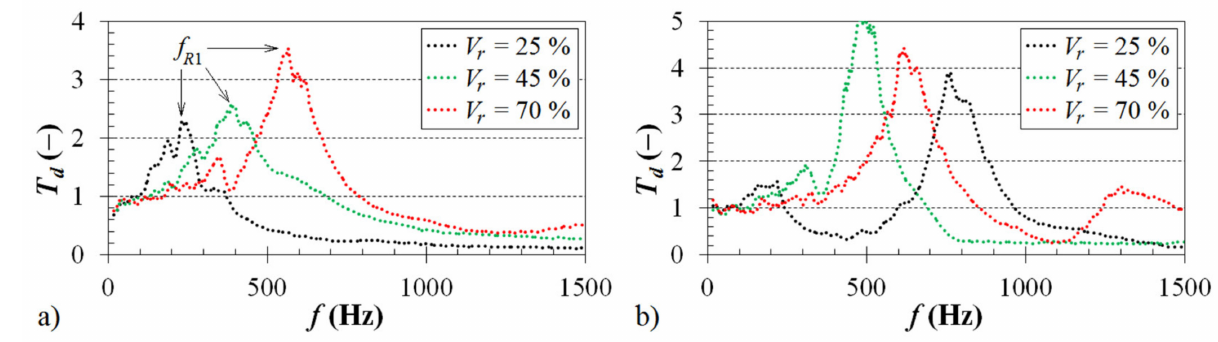
Figure 6. Influence of the sample volume ratio on the displacement transmissibility: ( a ) cell size a = 7 mm, inertial mass m i = 90 g; ( b ) cell size a = 10 mm, inertial mass m i = 0